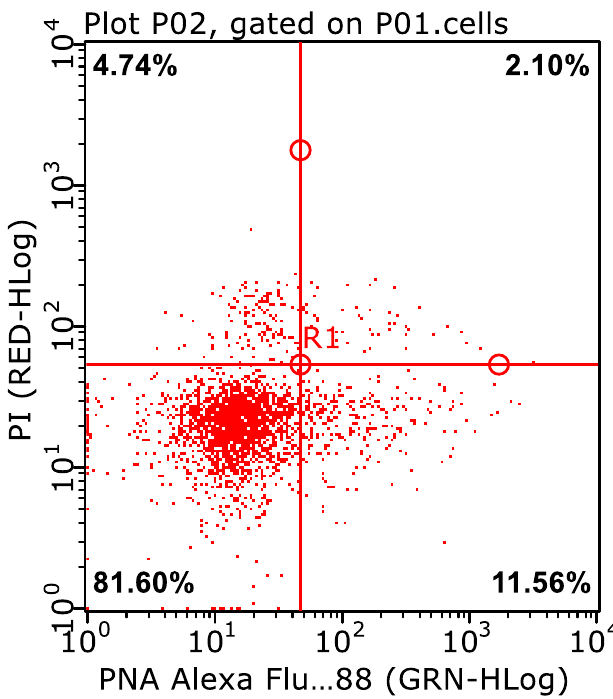
Figure 4. An example of a dot plot with live spermatozoa with intact acrosomes in the Experimental group in the lower left quadrant (81.6%): PNA- PI- (PNA, PNA Alexa Fluor 488–lectin from Arachis hypogaea ; PI, propidium iodide).